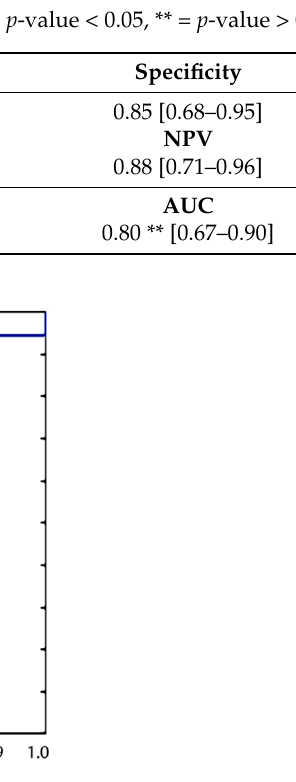
Figure 2. ROC-AUC obtained in testing the radiomic classifiers.